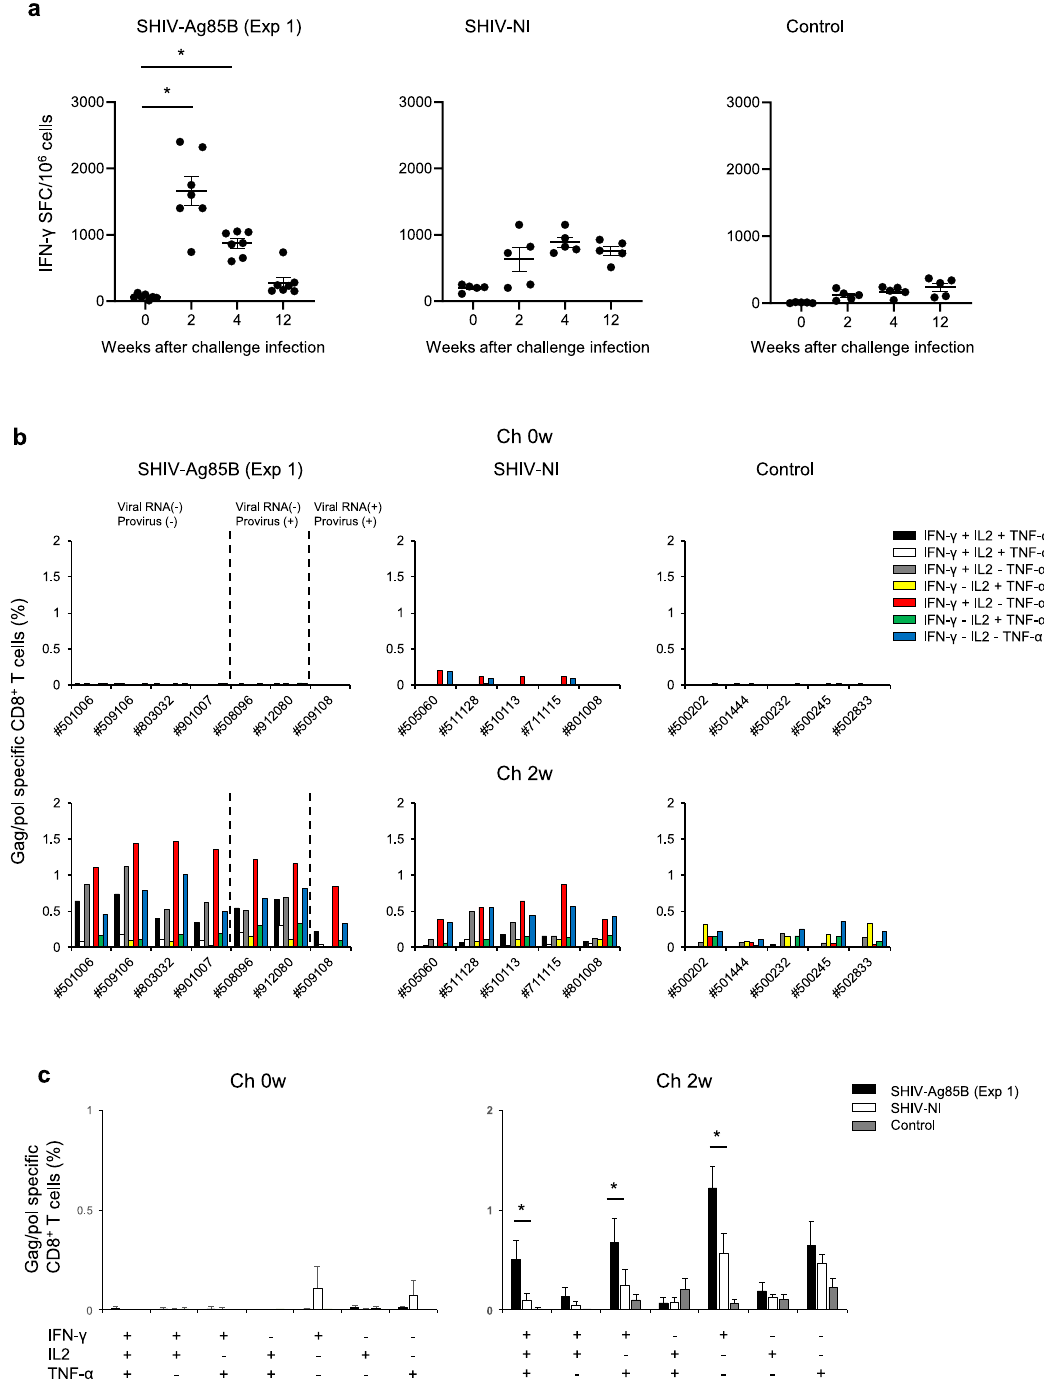
Fig. 7 Protective antigen-speci fi c T cell responses after pathogenic SHIV89.6P challenge. a Kinetics of Gag/pol-speci fi c IFN- γ -producing cells in SHIV-Ag85B (Exp 1)-inoculated macaques, SHIV-NI-inoculated macaques, and control macaques after SHIV89.6P challenge was determined by ELISPOT assays. PBMCs obtained at 0, 2, 4, and 12 weeks after the challenge were co-cultured for 9 h with autologous B-LCL cells that had been infected with a recombinant vaccinia virus expressing SIV Gag/pol. Antigen-speci fi c IFN- γ ELISPOT results are depicted as spots per 10 6 PBMCs. Each symbol shows one animal, and error bars represent means ± SEM. Statistical analysis was performed using Wilcoxon signed-rank test. * P < 0.05. b Percentages of Gag/pol-speci fi c CD8 + T cells producing IFN- γ , TNF- α , and IL-2 in SHIV-Ag85B (Exp 1)- inoculated macaques, SHIV-NI-inoculated macaques, and control macaques after SHIV89.6P challenge. The cytokine pro fi le in cells was determined by fl ow cytometry by gating for lymphocytes and CD8 + T cells. PBMCs obtained at 0 and 2 weeks after the challenge were co- cultured for 6 h with autologous B-LCL cells that had been infected with a recombinant vaccinia virus expressing SIV Gag/pol. c Mean percentages of Gag/pol-speci fi c induction of single or multiple cytokines in SHIV-Ag85B (Exp 1)-inoculated macaques, SHIV-NI-inoculated macaques, and control macaques after SHIV89.6P challenge. Error bars represent means ± SEM. Statistically signi fi cant differences between SHIV-Ag85B (Exp 1) and SHIV-NI were determined by using Student ’ s t test. * P <